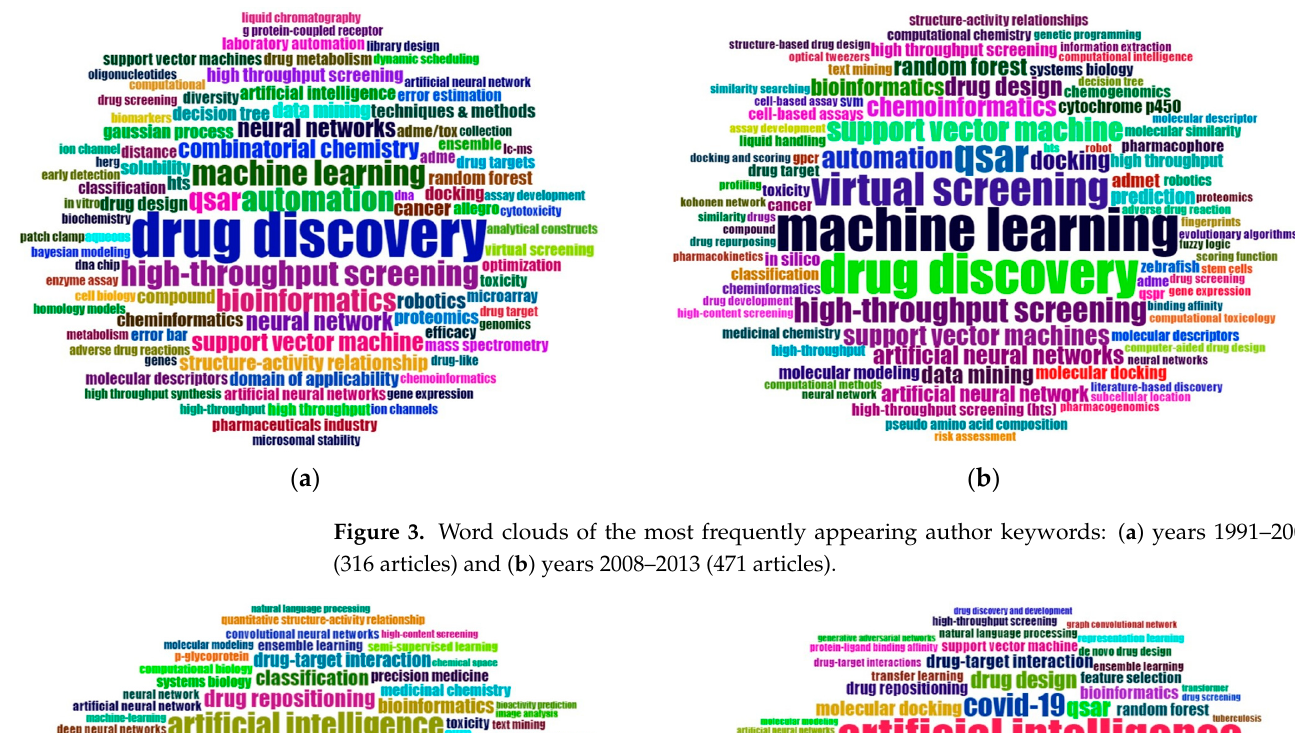
Figure 3. Word clouds of the most frequently appearing author keywords: ( a ) years 1991–2007 (316 articles) and ( b ) years 2008–2013 (471 articles).